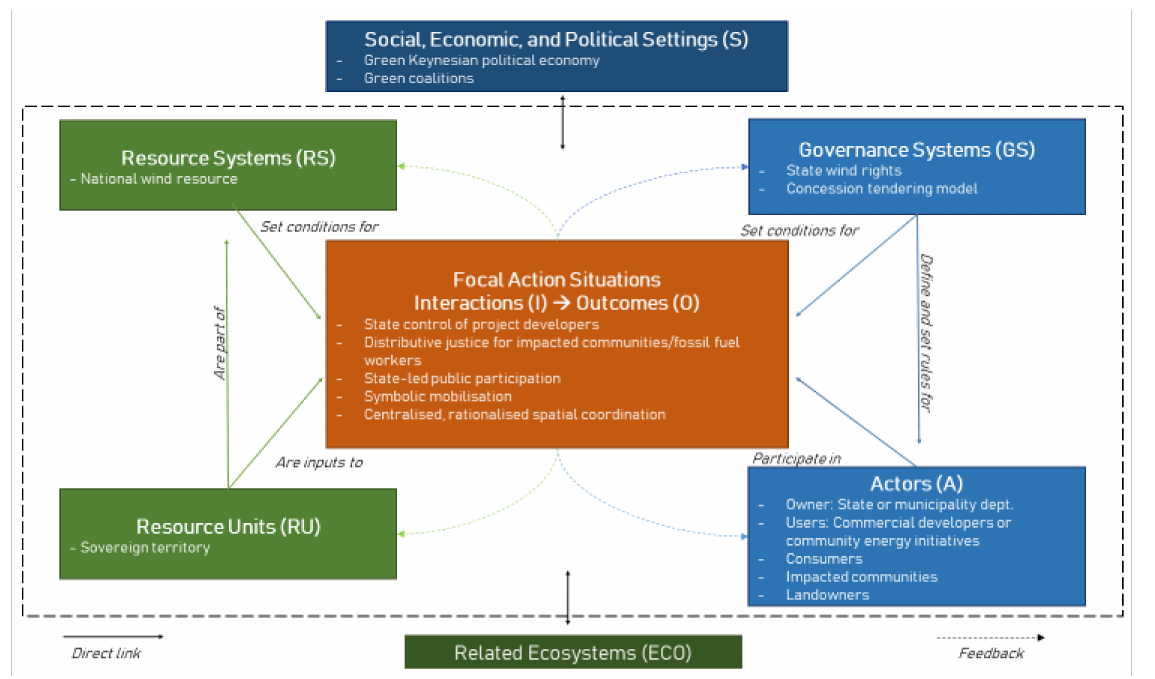
Figure 4. Scenario 2: Social-ecological model for wind energy under state-owned wind rights. Source: authors, based on Ostrom’s SES framework.